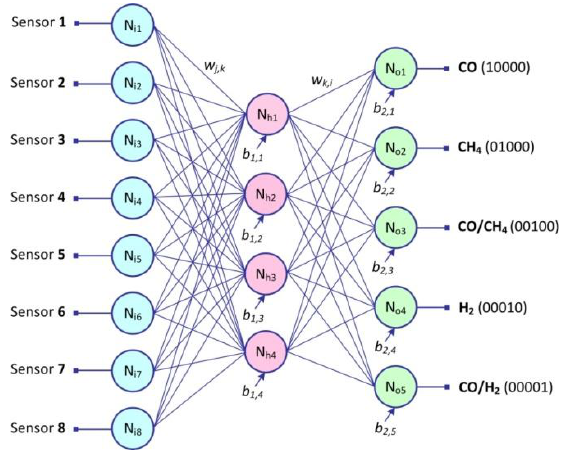
Figure 7. Simplified graphic representation of ANN with structure